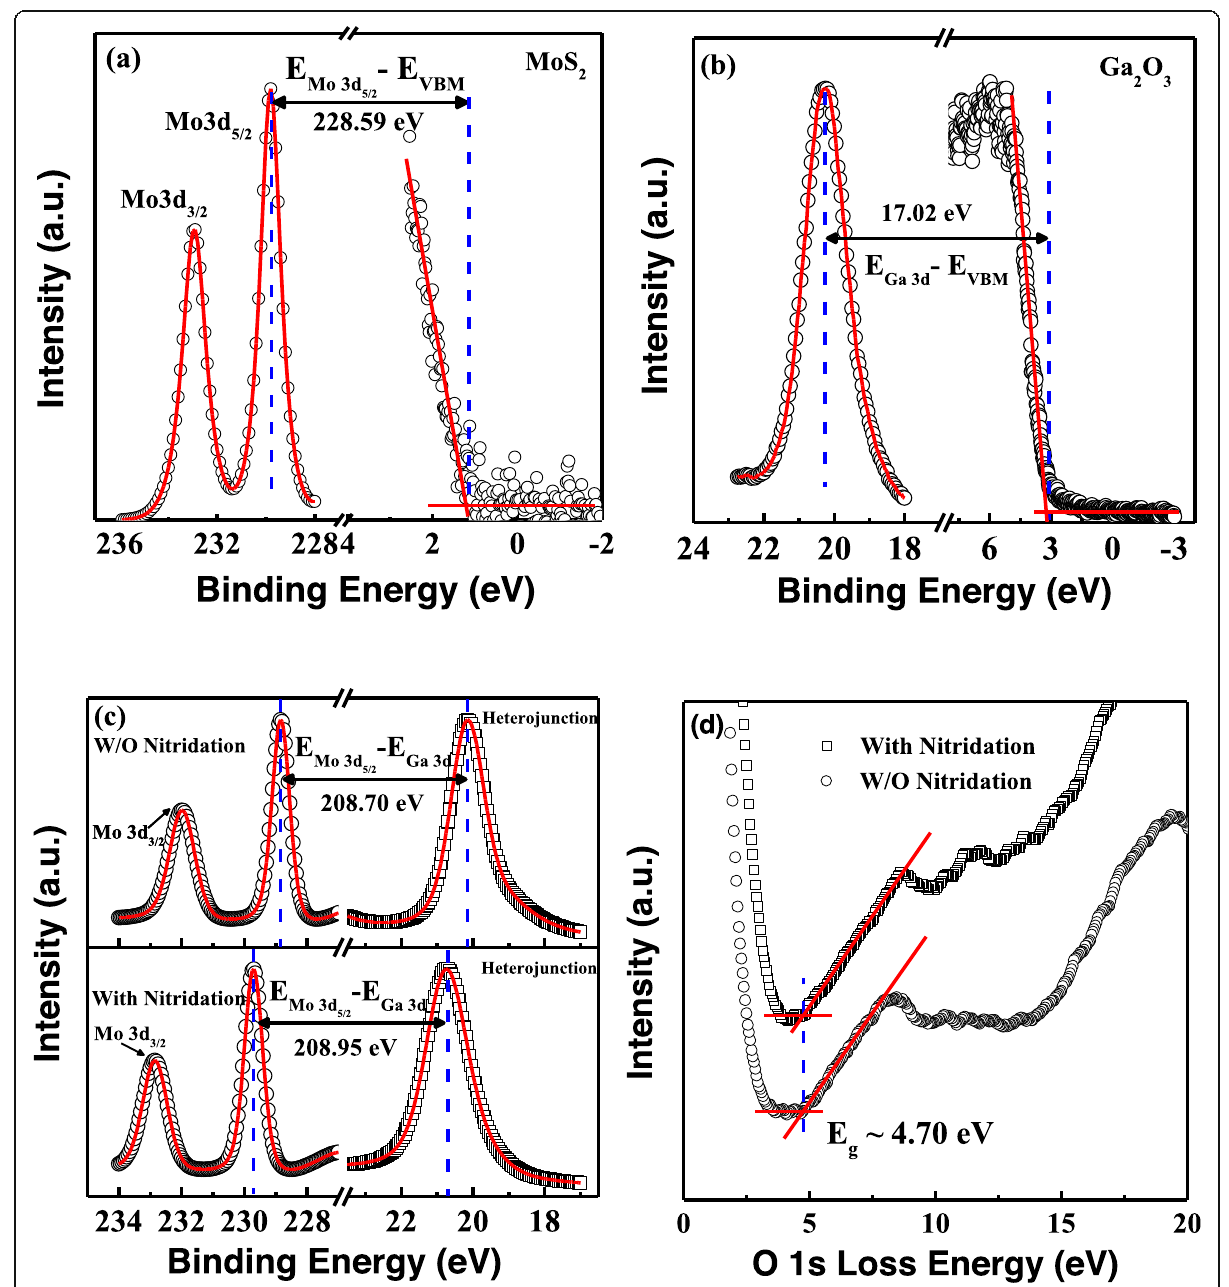
Fig. 4 a XPS spectra of Mo 3d CL and valence band from few-layer MoS 2 . b XPS spectra of Ga 3d CL and valence band from β -Ga 2 O 3 substrate. c XPS spectra of Mo 3d and Ga 3d CLs for fabricated MoS 2 / β -Ga 2 O 3 heterojunction with/without surface nitridation. d XPS spectra of O 1 s CL energy loss of β -Ga 2 O 3 substrate with/without surface